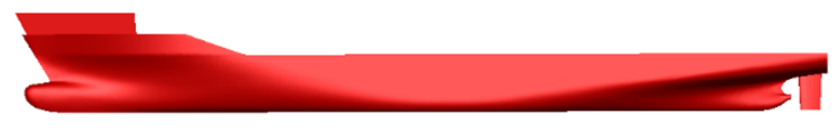
Figure 1. KCS hull geometry. Table 1. Main particulars of the ship hull.